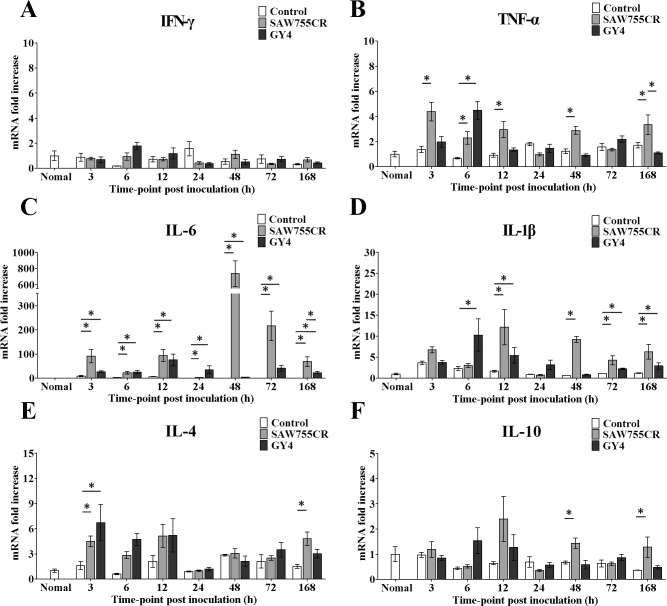
Quantitative real-time PCR assay of gene expression of IFN-γ (A), TNF-α (B), IL-6 (C), IL-1β (D), IL-4 (E) and IL-10 (F) in ALA of hamsters. Expression levels of cytokine genes in liver tissues from hamsters inoculated with culture medium or 1×106 trophozoites of E. histolytica SAW755CR strain or E. nuttalli GY4 strain are shown as 2-ΔΔCt of the target gene relative to β-actin and normalized using the corresponding values in normal hamster. Y axes are numbers correspond to the fold increase over 1.0, assigned to normal hamster. Error bars represent standard errors of the mean calculated from three independent replicates. The abscissa shows the time post-inoculation. * P < 0.05.